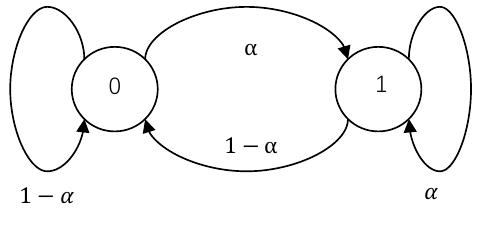
Figure 2. State transition diagram of discrete memoryless erasure